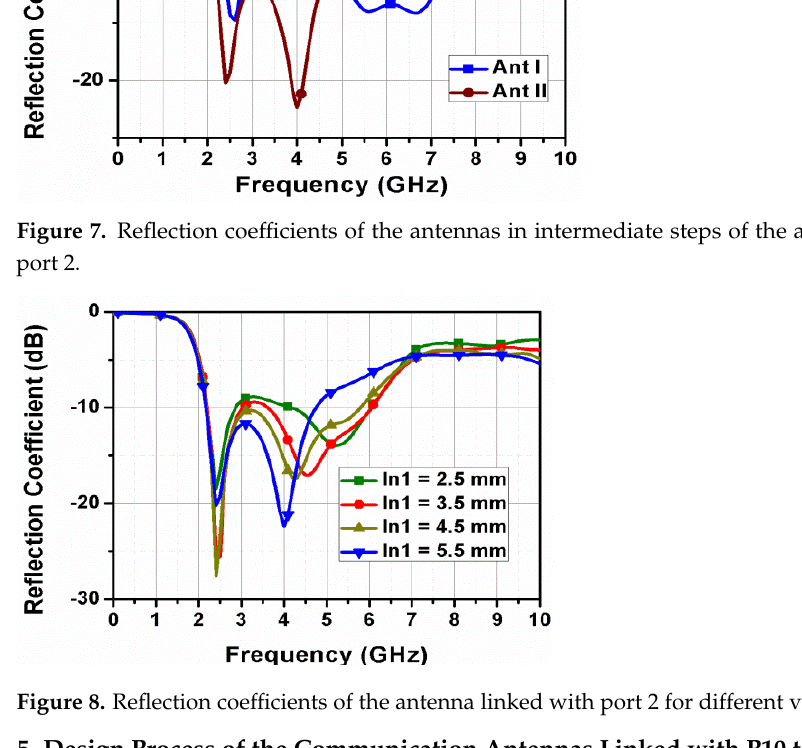
Figure 8 . Reflection coefficients of the antenna linked with port 2 for different values of ln1 .